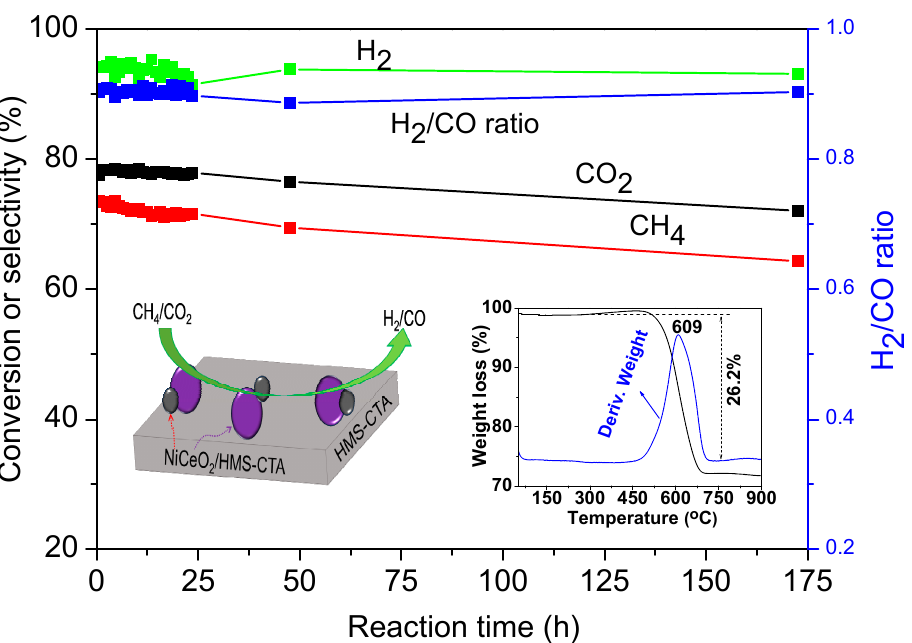
Figure 7. DRM activity results for the 5Ni15CeO 2 /HMS-CTA catalyst, the left inserted image stands for the reaction mechanism, the right inserted image presents the weight loss curve of the used catalyst.